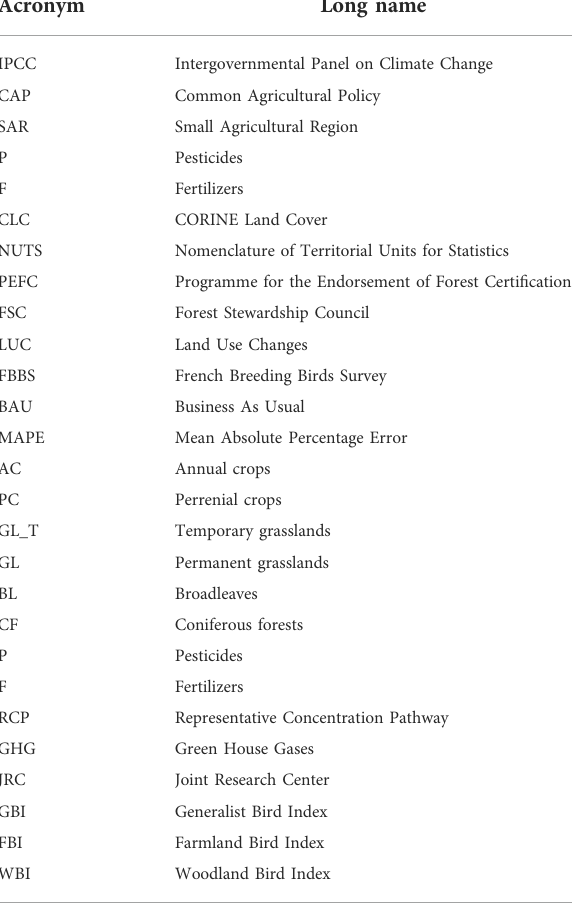
TABLE 1 Table of main acronyms as they appear in the main